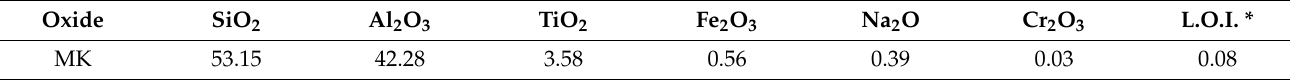
Table 1. Chemical composition of metakaolin (wt.%).